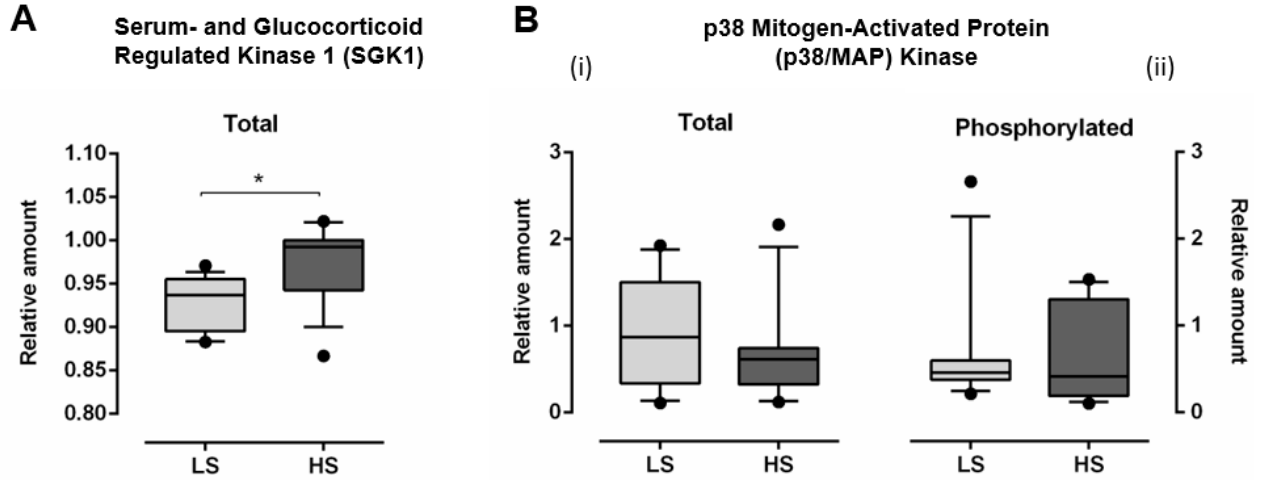
Figure 5. The effect of a 7-day high-salt diet on relative amount of total serum- and glucocorticoid regulated kinase 1 (SGK1) ( A ) and total ( B-i ) and phosphorylated ( B-ii ) p38 mitogen-activated protein (MAP) kinase ( B ) in young healthy individuals. N = 30 (15 women and 15 men). LS—low salt; HS—high-salt; N—number of subjects). Data are presented as box-and-whisker plots 10 to 90 percentiles. Paired t -test, * p < 0.05, LS diet vs. HS diet.